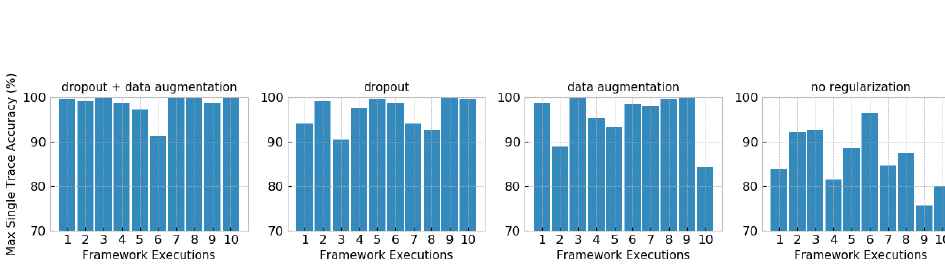
Figure 20: Random CNN hyperparameters: maximum single trace accuracy on the cswap-pointer dataset for ten different framework executions and for random CNN hyper- parameters.